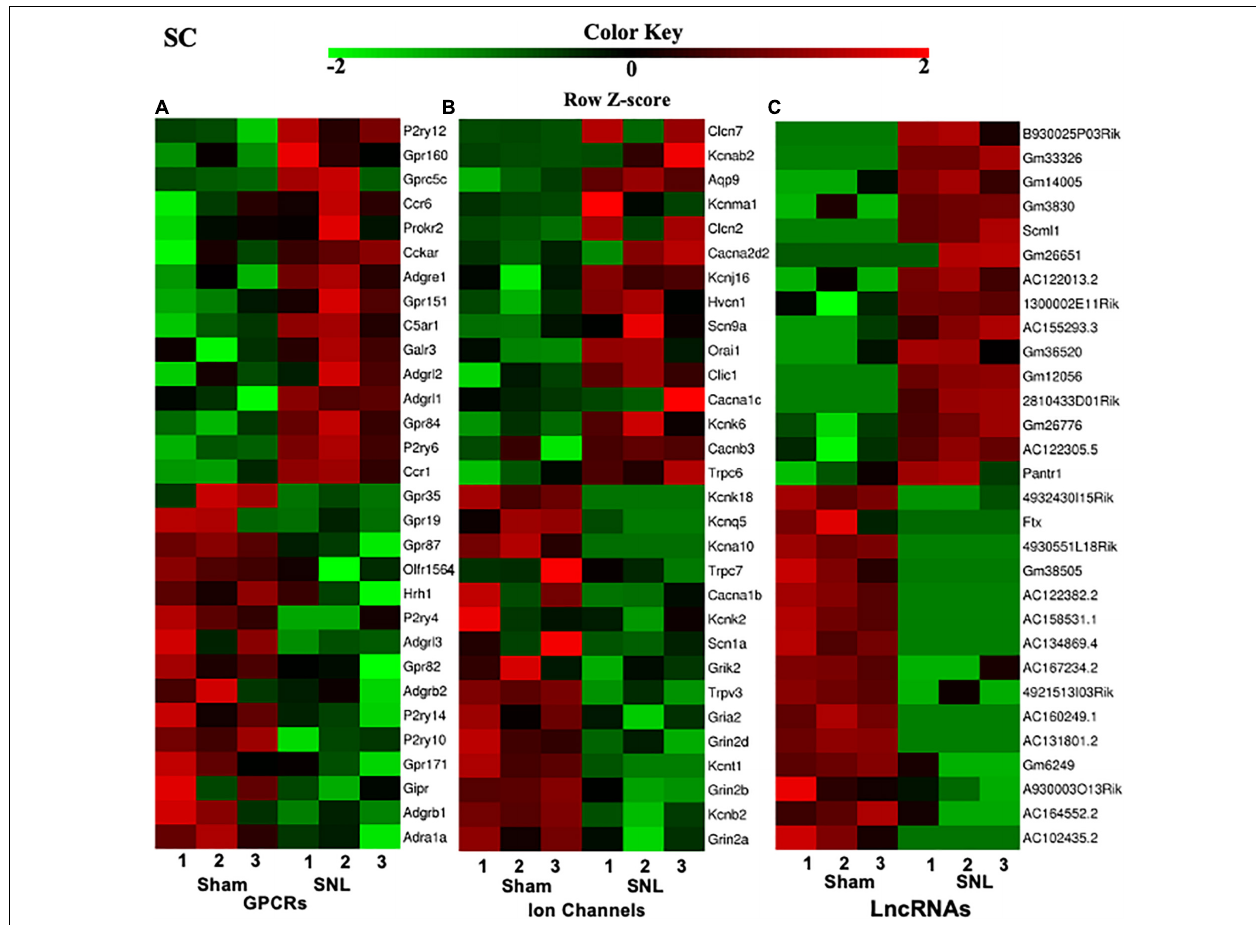
FIGURE 3 | Heatmaps of the representative differentially expressed genes (DEGs) in the spinal cord after nerve injury. (A-C) , Top 15 up- and downregulated genes of G protein-coupled receptors (A) , ion channels (B) , and lncRNAs (C) in the fourth lumbar spinal cord on day 7 after SNL. Colors in the heatmaps indicate the Row Z-score among the different datasets. The up- and downregulated genes are colored in red and green, respectively. n = 9